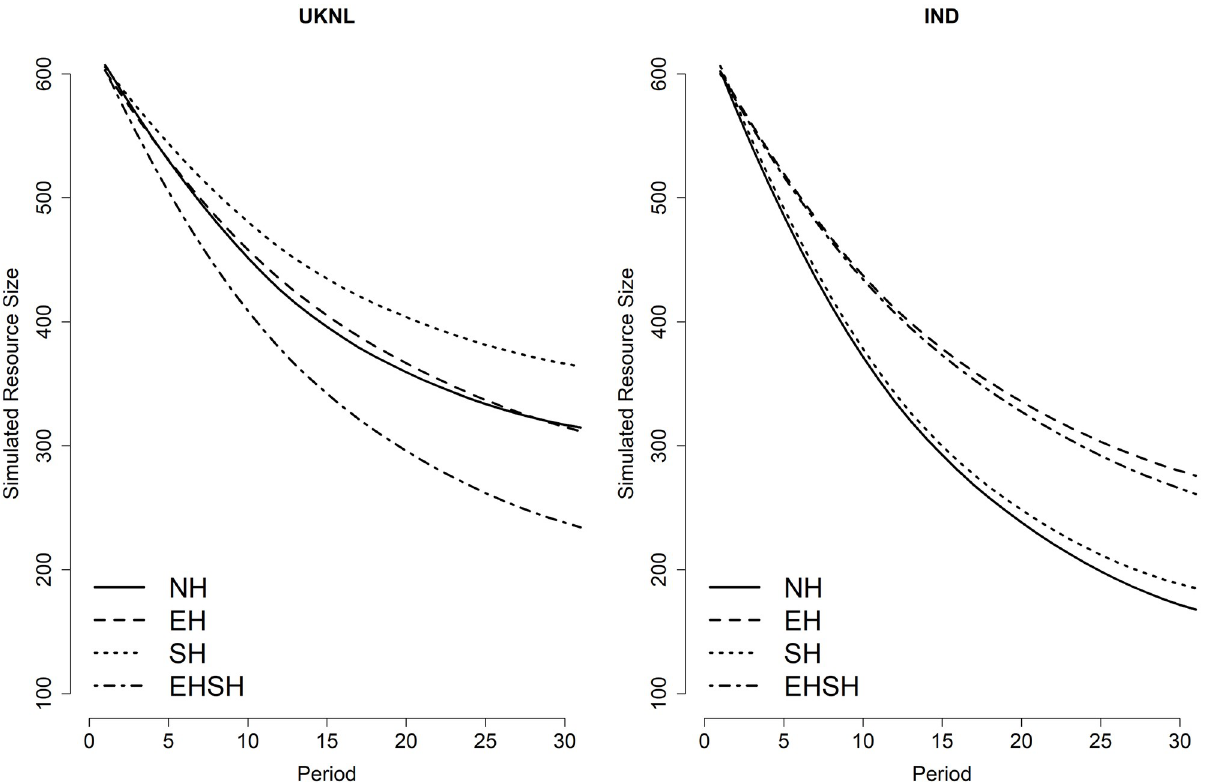
Fig 12. Smoothed simulated average resource size per treatment per